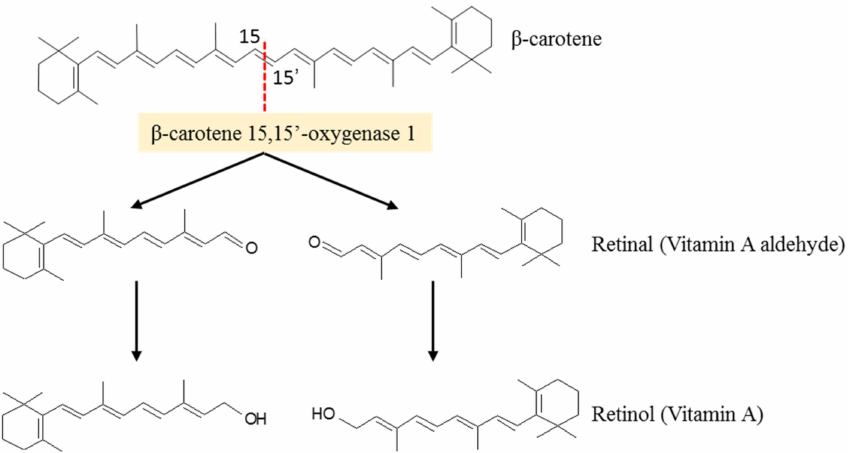
Figure 4. Enzymatic cleavage of β -carotene produces two molecules of retinol (vitamin A) (adapted from [48]).